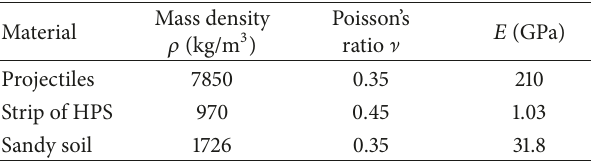
Table 1: Material parameters in LS-DYNA.